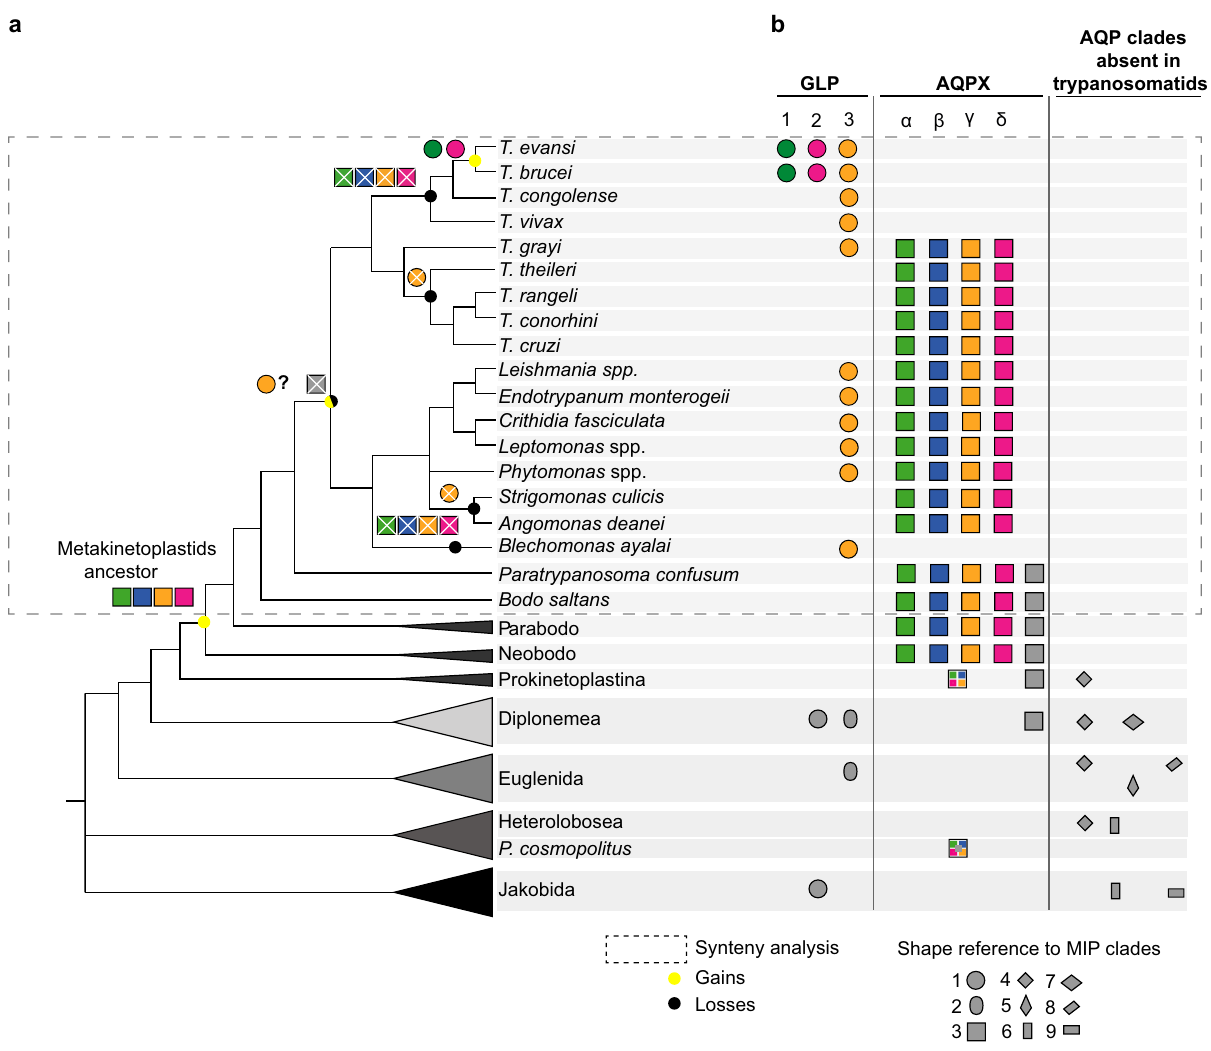
Fig. 6 Proposed evolutionary history of Trypanosomatid MIPs. a Cladogram showing the current accepted evolutionary relations inside the Discoba supergroup for the species analyzed in this work. b The MIPs repertoire for each species or group of species is represented by geometric shapes (proposed homologous genes share the same shape). Each shape is linked to a number in the references, and a number connects to the preliminary phylogenetic tree from Fig. 3. A dashed line square delimits the taxonomic groups represented by the syntenic analysis. Inside Metakinetoplastina, orthologs are represented in the same color. Inside the AQPX clade, for simplicity and because the phylogenetic relationships of some AQPXs are not fully resolved, gray squares may represent more than one homologous isoform. Multicolor squares represent ancestral homologs of trypanosomatid AQPXs. Over the cladogram, a proposed scheme of gains and losses, of GLPs and AQPXs, is